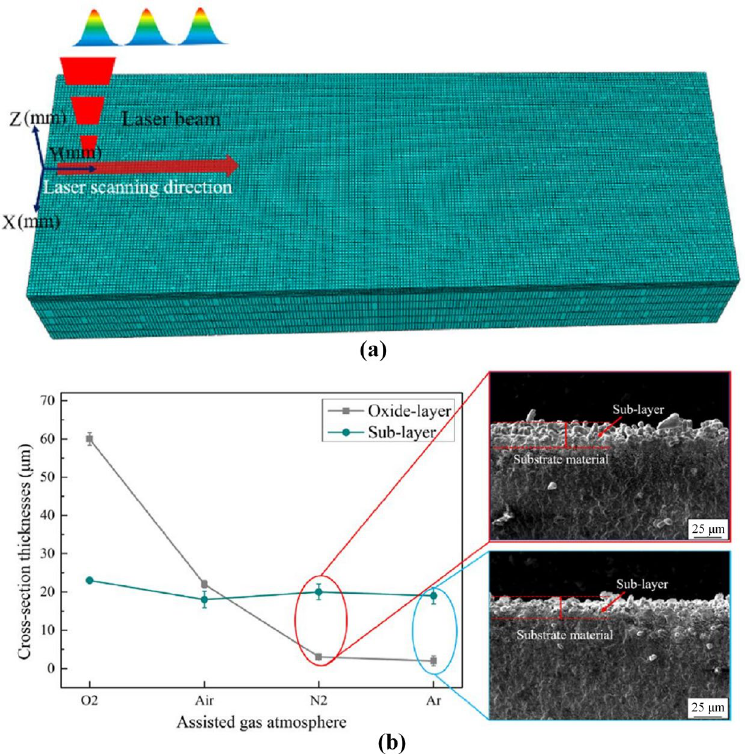
Figure 4. Finite element simulation for laser machining carbide-based UHTCMCs. ( a ) Nanosecond laser-induced controlled oxidation of TiB 2 –TiC ceramic composites for subsequent micro-milling; ( b ) sectional thickness of the metamorphic layer in the auxiliary gas environment. Reprinted/adapted with permission from Ref. [118]. Copyright 2022, Elsevier.